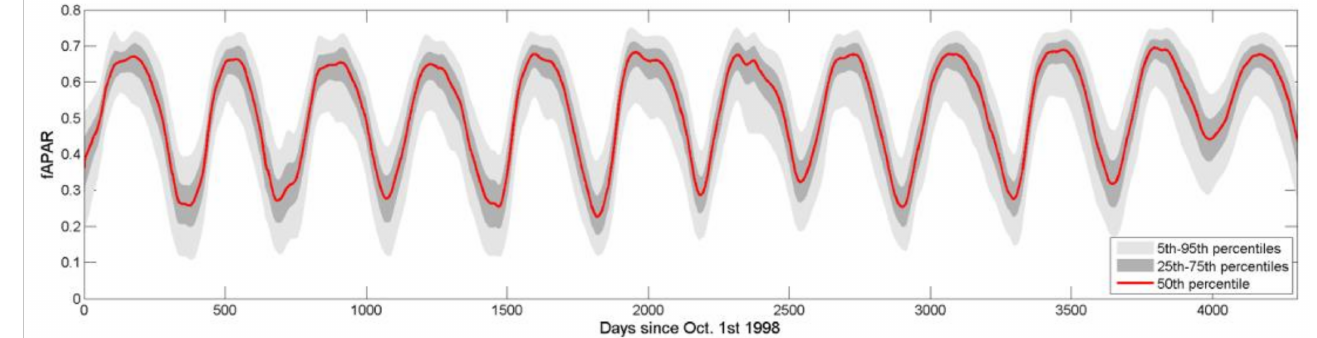
Figure 26. Distribution of smoothed time series by Duveiller et al. [160]; the presentation demonstrated the 5th–95th, 25th–75th, and 50th percentiles of pixel with a crop specific spatial purity above or equal to